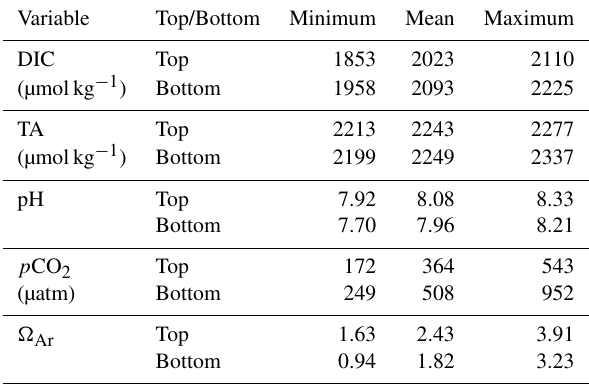
Table 2. Carbon system variables summary statistics aggregating all six sampling